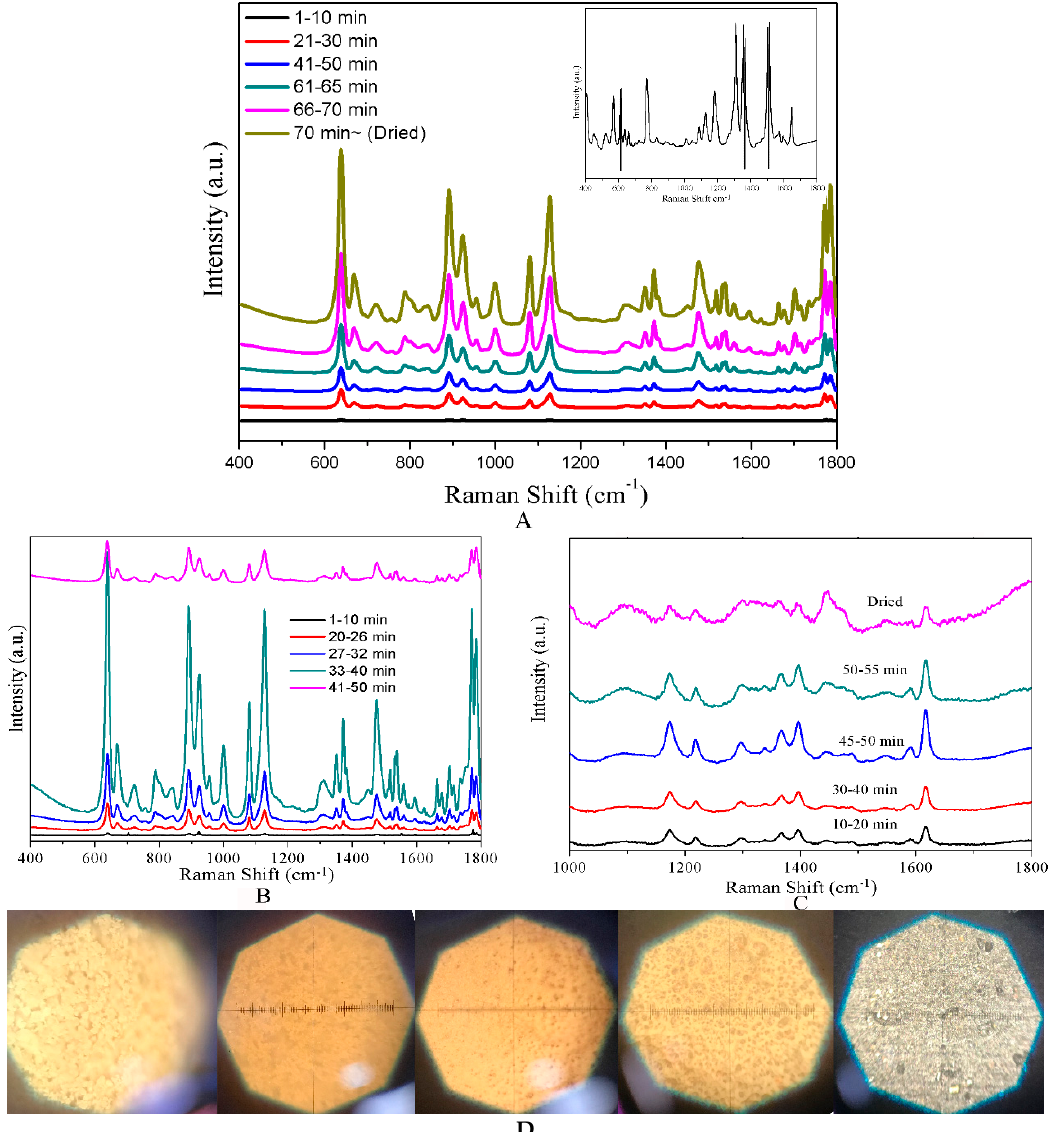
Figure 2. ( A ) SERS spectra for dynamic detection of 5 × 10 − 5 M MG. ( B ) SERS spectra of 5 × 10 − 6 M MG detected with CF-Ag prepared using 15 mM AgNO 3 from wet to dry. ( C ) SERS spectra of 10 − 7 M MG detected with CF-Ag prepared using 15 mM AgNO 3 from wet to dry (spectra above were averaged from five measurements). ( D ) Photographs of CF-Ag recorded via a microscope from wet to dry. To estimate the homogeneity of CF-Ag NPs, 32 spectra randomly selected were obtained and were recorded for one sample (5 × 10 − 4 M MG) in the same condition of dry (Figure 3A). Additional details and1395 cm − 1 . The results indicated good homogeneity with RSD = 9.8% for the band at 1172 cm − 1 and RSD = 10.2% for the band at 1395 cm − 1 (Figure